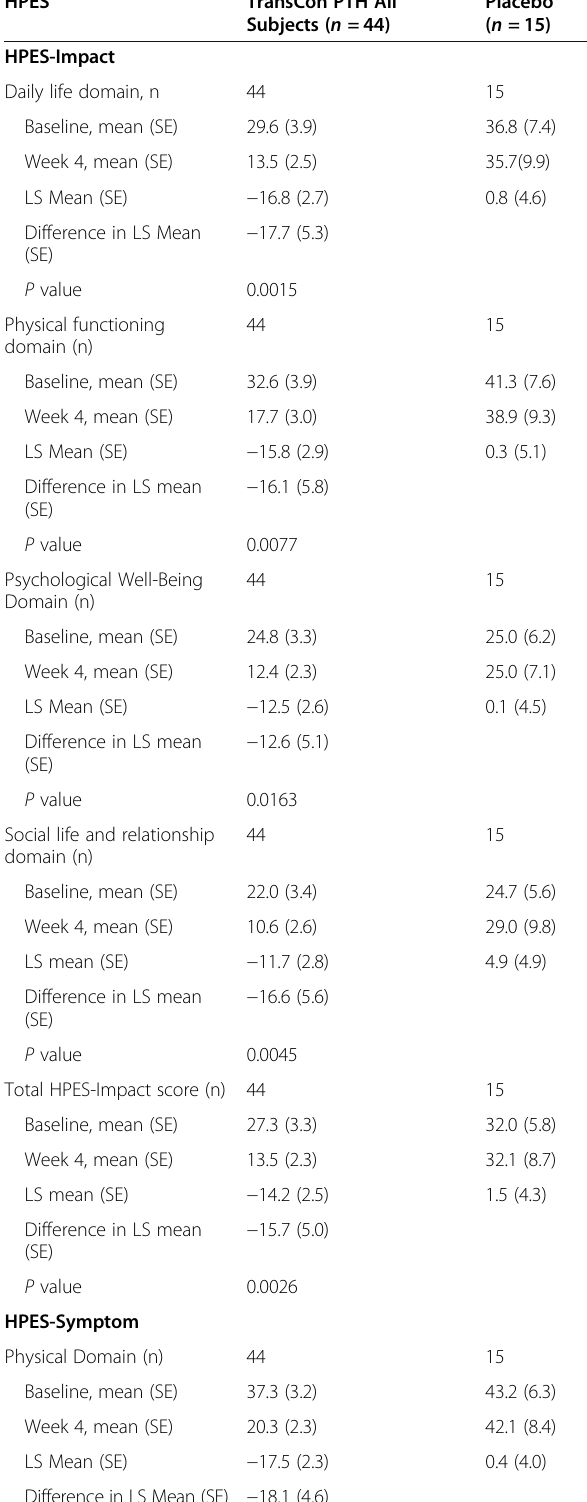
Table 10 Summary of HPES-Impact and HPES-Symptom Scales for TransCon PTH vs. placebo by ANCOVA (Full analysis set; N =